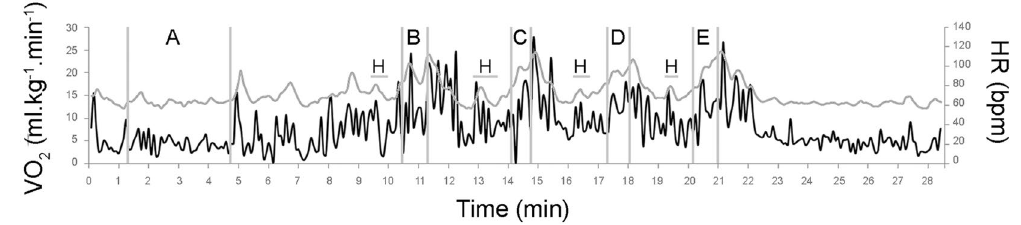
Figure 1. Typical oxygen consumption (black line) and heart rate (grey line) behaviour during a bout of swimming exergame during the rest period ( A ), front crawl ( B ), backstroke ( C ), breaststroke ( D ), butterfly ( E ) and Hype phase ( H